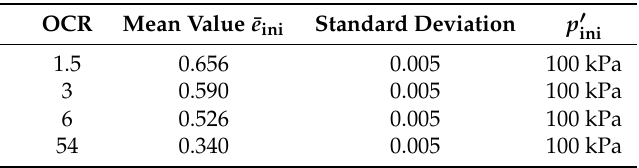
Table 2. Initial conditions for the FE